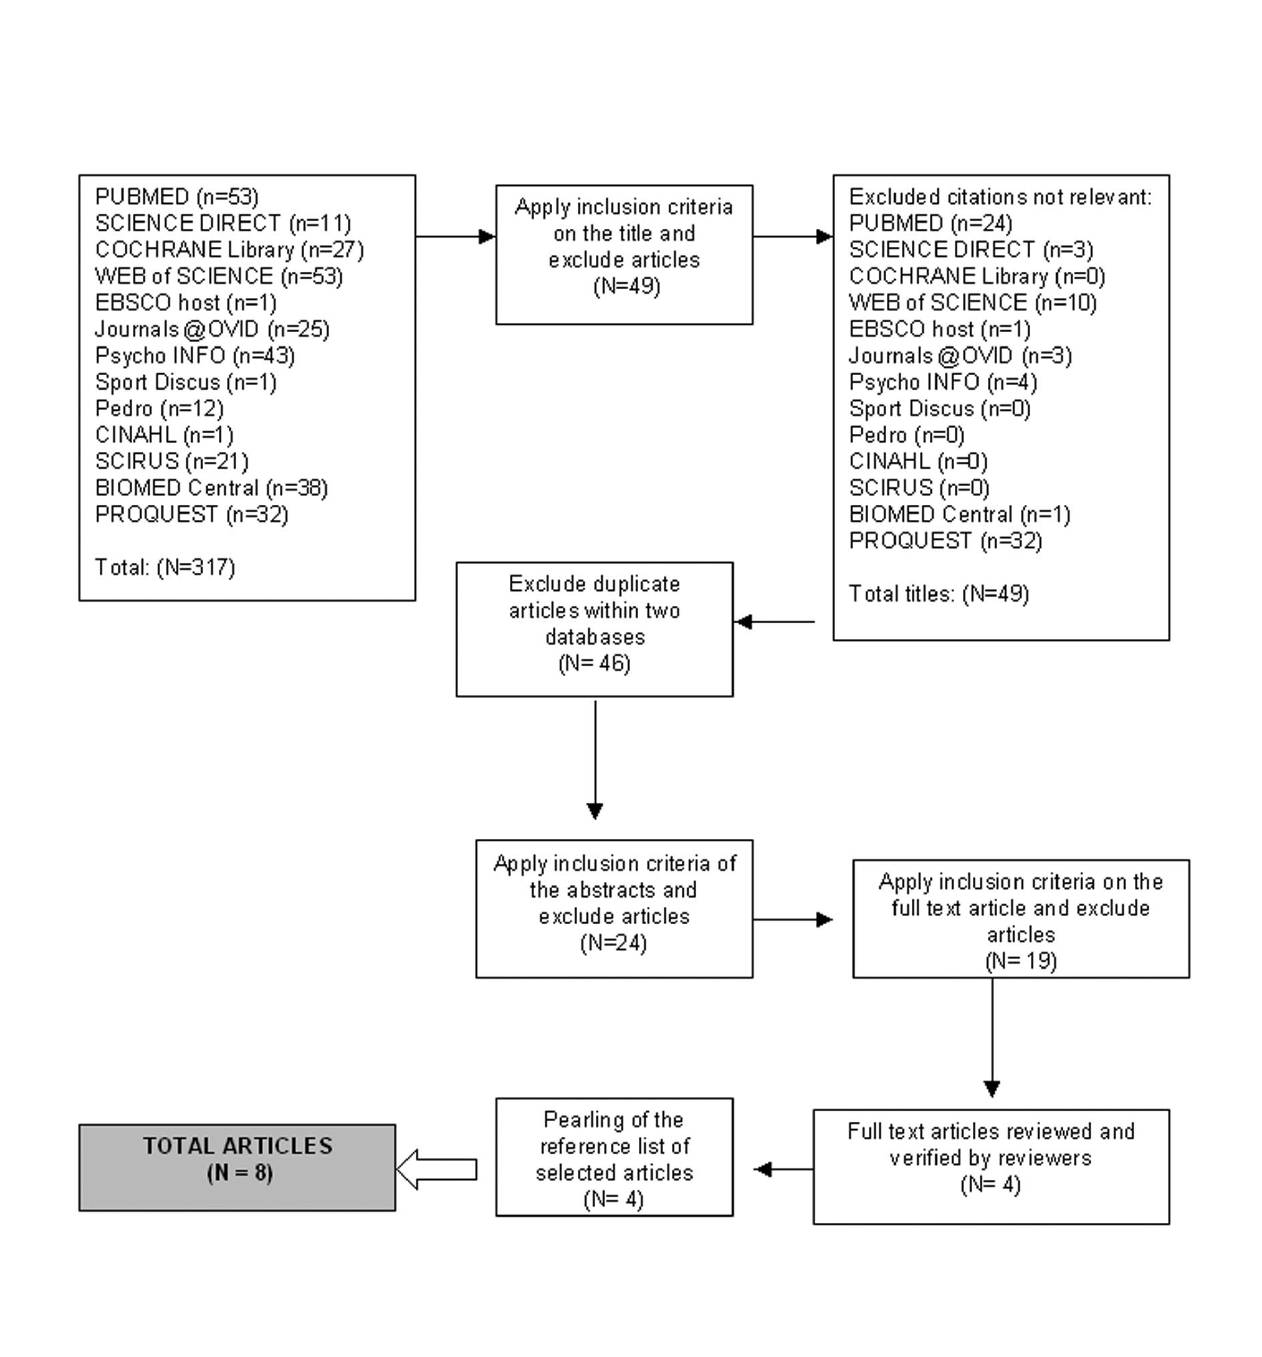
Figure 1: Search